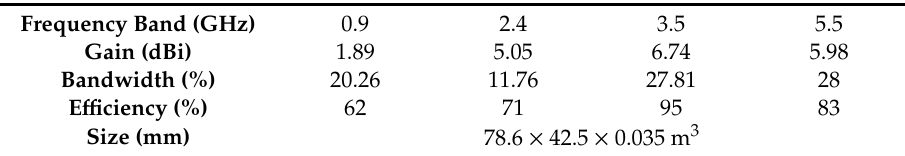
Figure 16. Simulated and measured electric field radiation patterns of the proposed CPW antenna at: the ( a ) XY-Plane; ( b ) YZ-Plane. Table 3. Summary of the antenna